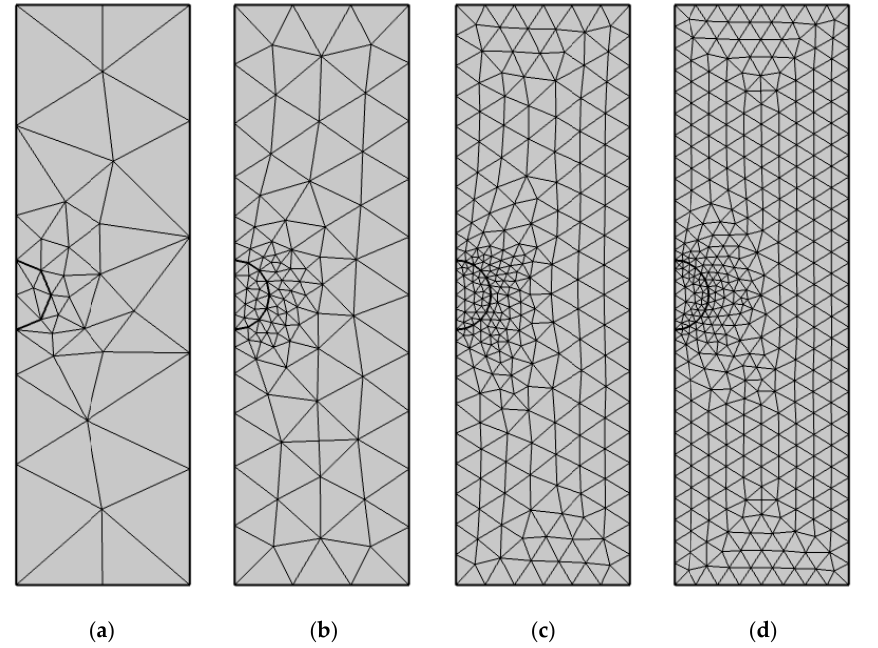
Figure 4. Four types of meshes. ( a ) Coarser, ( b ) Coarse, ( c ) Fine, ( d ) Finer. Table 1. Comparison of 10 nodal electric potentials of four kinds of meshes.